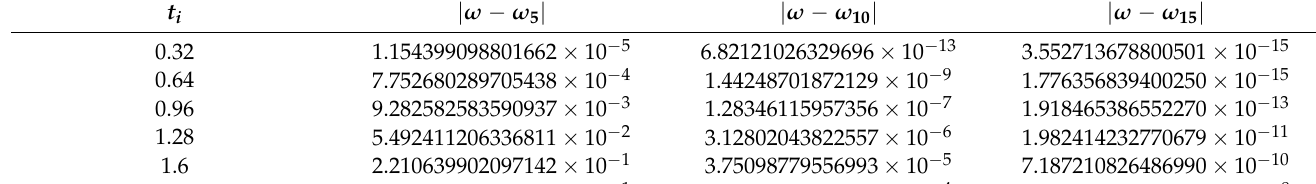
Table 5. Comparison of absolute errors of the nonlinear time-FGBPM (32).